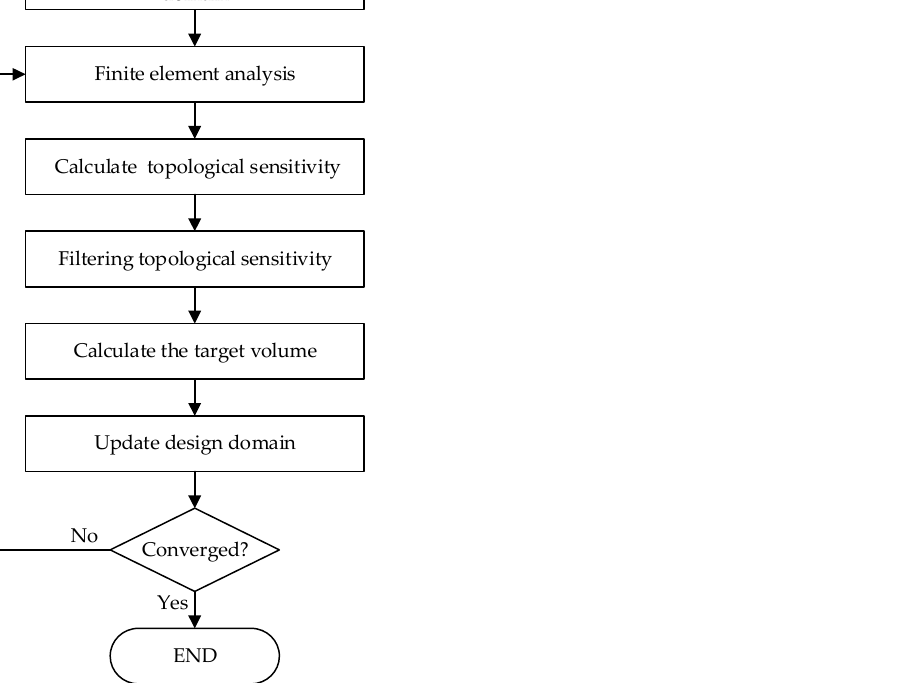
Figure 3. Flowchart of bi-directional evolutionary structural optimization (BESO) based on topological sensitivity.